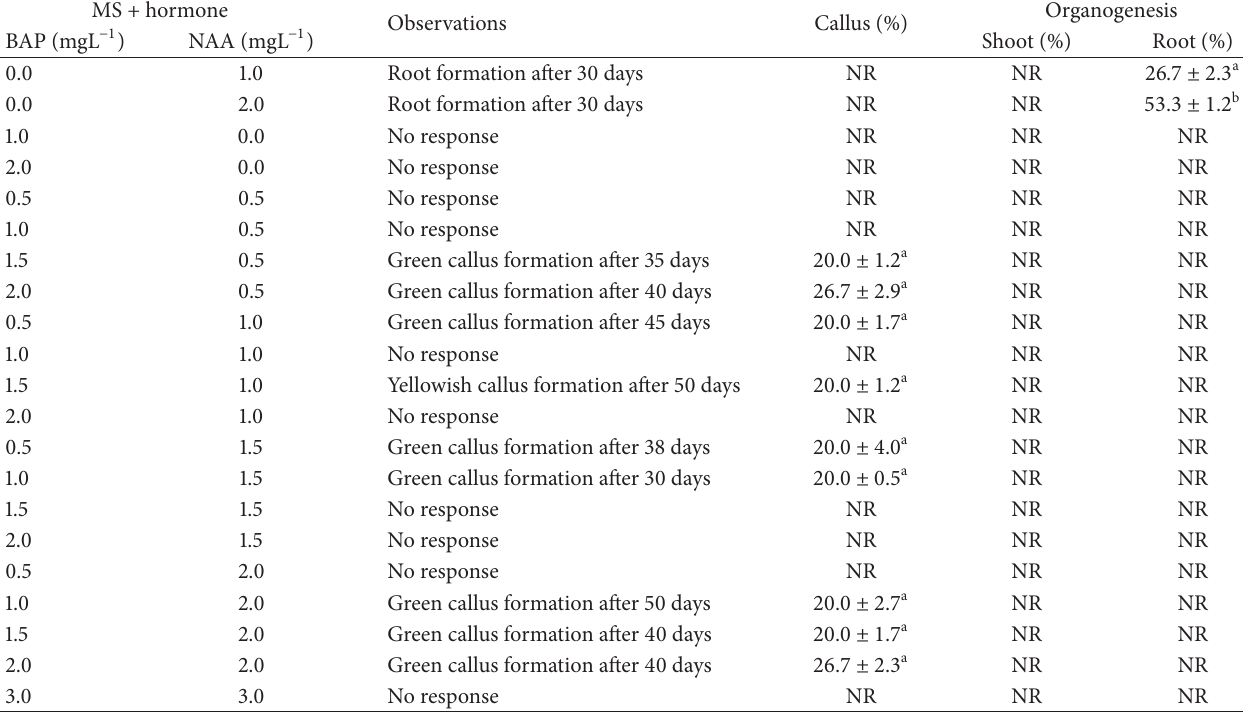
Table 3: The effects of different combinations and concentrations of BAP and NAA on leaf explants of Citrus hybrids , cultured on solid MS media at 25 ± 1 ∘ C. Cultures were maintained at 16 hours of light and 8 hours of darkness, with 1000 lux intensity of light. MS + hormone Observations Callus (%)